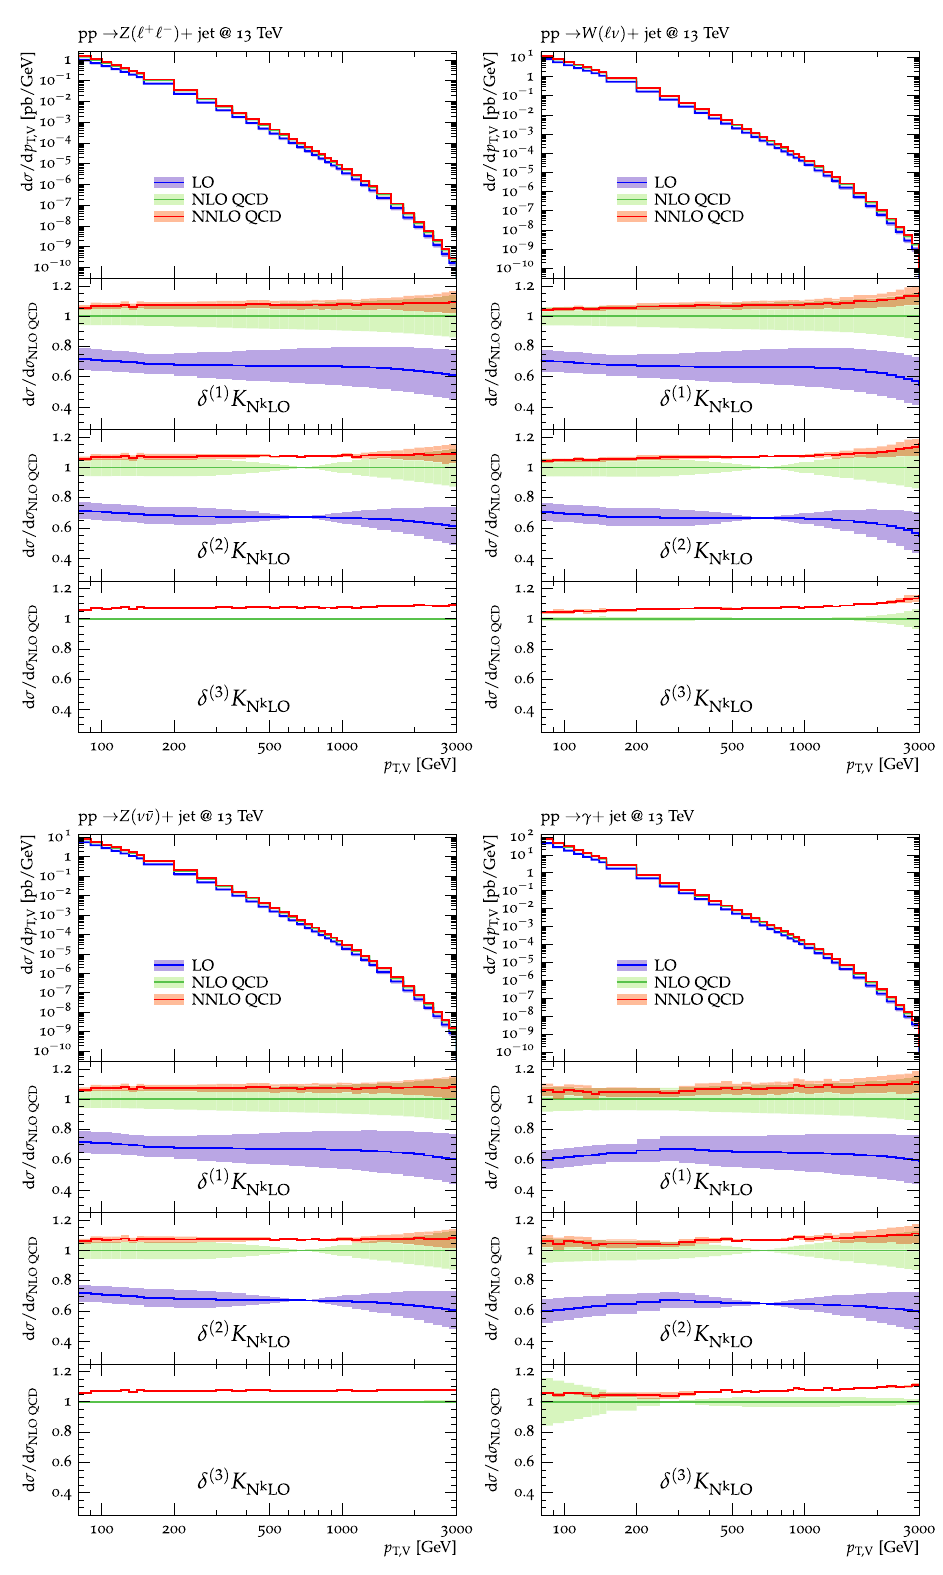
Fig. 18 Higher-order QCD predictions and uncertainties for various pp → V + jet processes at 13TeV. Absolute predictions at LO and NLO QCD are displayed in the main frame. In the ratio plots all results